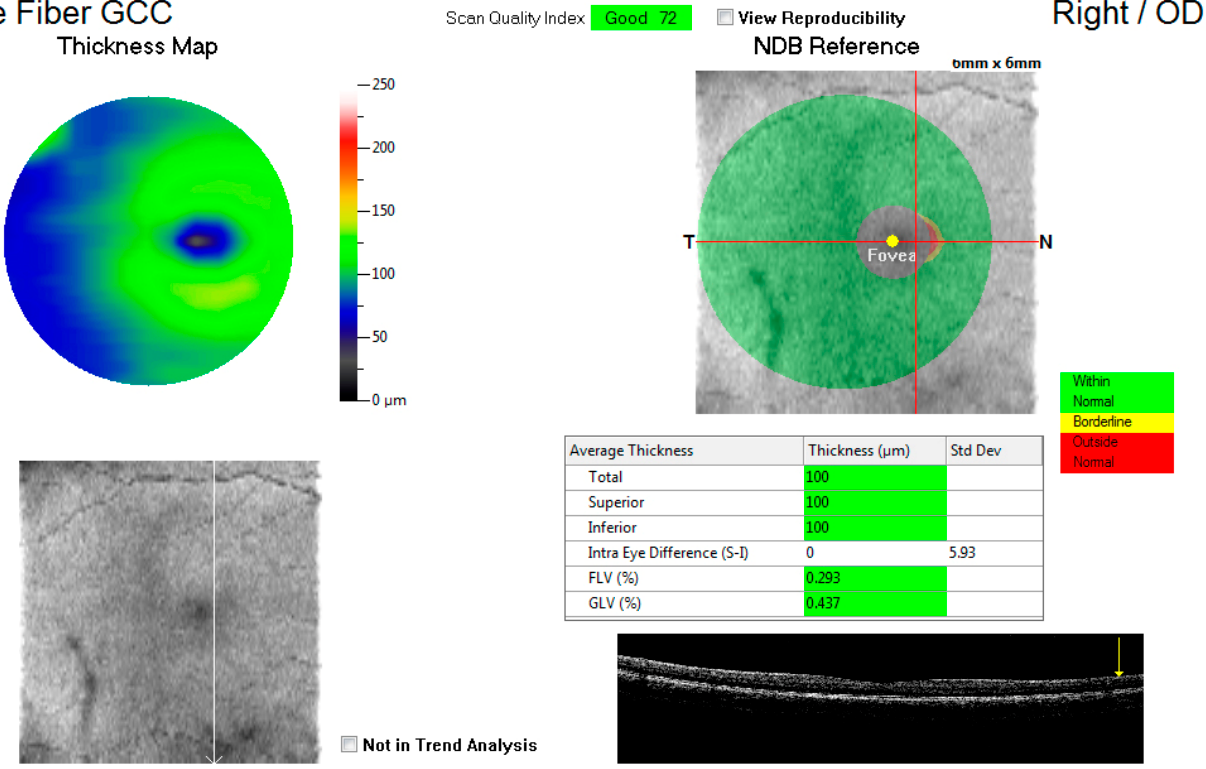
Figure 1. An illustration of the ganglion cell complex (GCC) thickness map at the macula.